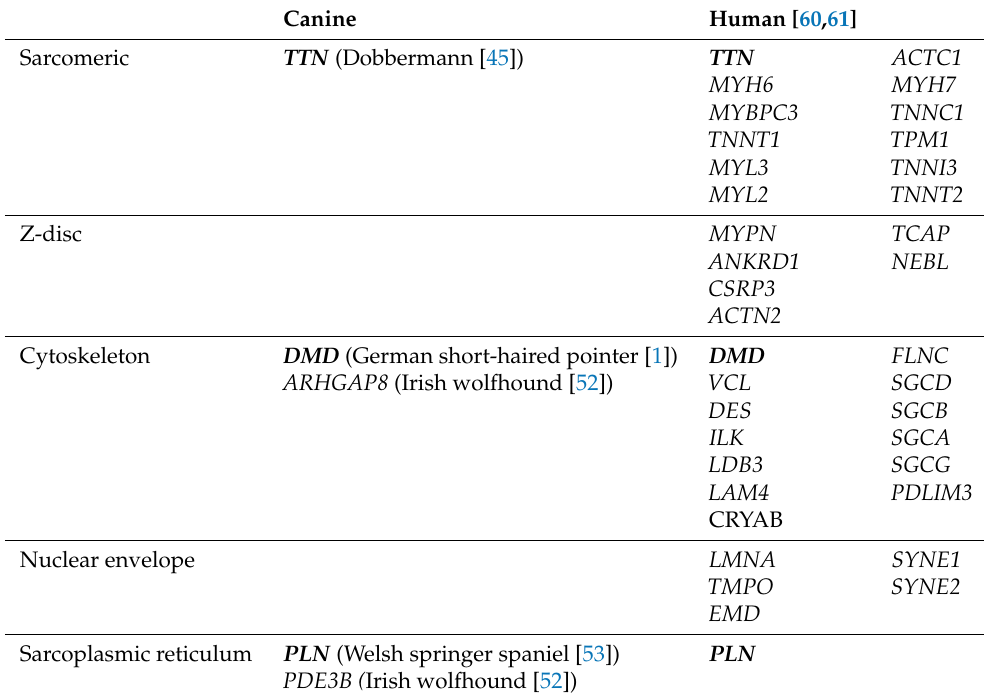
Table 1. Comparison of mutated genes involved in the development of DCM in humans and dogs. Overlap is found in genes that encode for cytoskeleton, sarcomeric, and other unclassified proteins. Bold: overlapping genes between